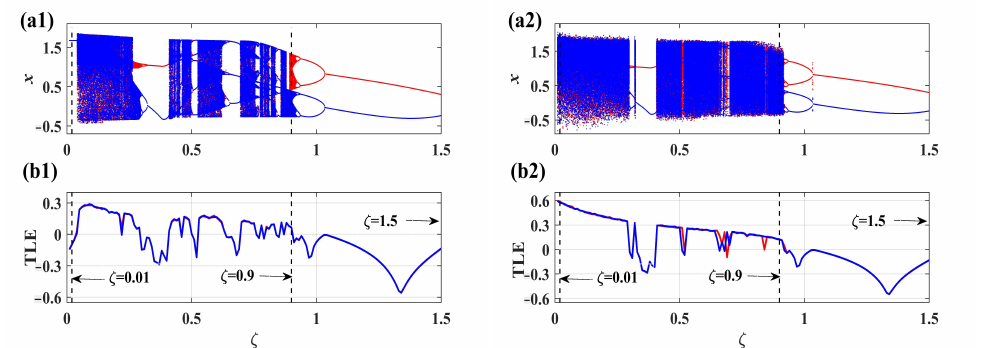
Figure 4. Bifurcation diagrams and the TLE with the variation of damping coefficient ζ . ( a1 , a2 ) Multivalued bifurcation diagram of DR and EMR ( σ = 0.01); ( b1 , b2 ) Multivalued TLE of DR and EMR ( σ = 0.01). The blue dots and red dots are obtained under the initial con- ditions [ x 0 , x 1 , x 2 , x 3 , x 4 ] = [ − 0.5,0,0,0,0 ] , [ ˙ x 0 , ˙ x 1 , ˙ x 2 , ˙ x 3 , ˙ x 4 ] = [ 1.0,0,0,0,0 ] , [ v 0 , v 1 , v 2 , v 3 , v 4 ] = [ 1.0,0,0,0,0 ] (IC-1) and [ x ] = [ 1.0,0,0,0,0 ] , [ ˙ x ] = [ − 0.5,0,0,0,0 ] , 0 , x 1 , x 2 , x 3 , x 4 0 , ˙ x 1 , ˙ x 2 , ˙ x 3 , ˙ x 4 [ v ] = [ 1.0,0,0,0,0 ] (IC-2), 0 , v 1 , v 2 , v 3 , v 4